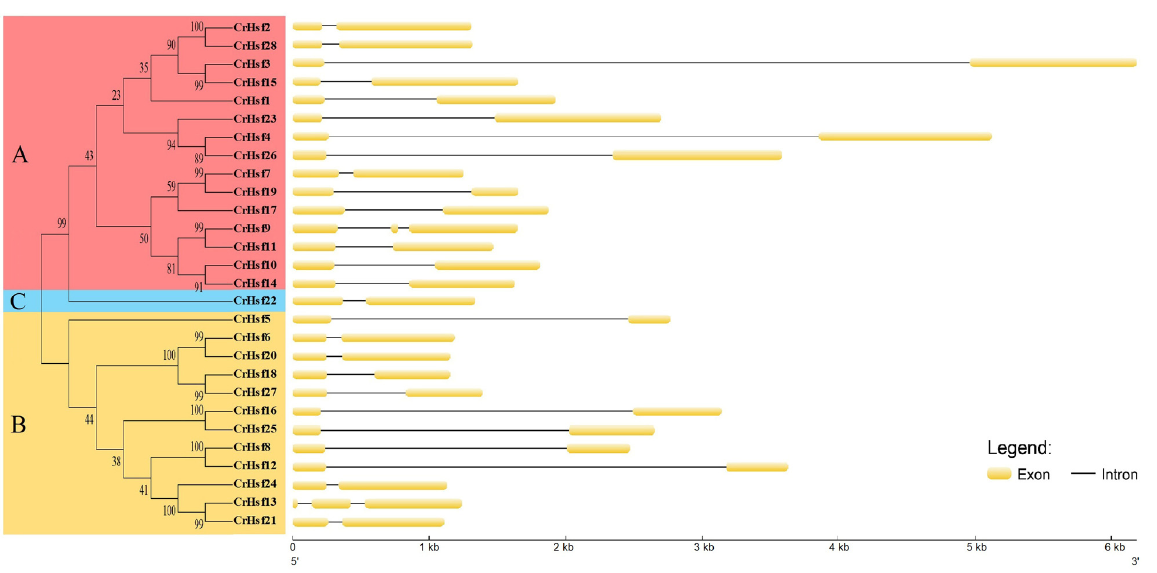
Figure 4. The exon-intron organization of the CrHsf genes constructed with GSDS 2.0 (http://gsds.cbi.pku.edu.cn/, accessed on 1 May 2022). The left capital letters “A, B, and C” and corresponding phylogenetic tree represent different groups marked with different colors (red for Group A, yellow for Group B, and blue for Group C).